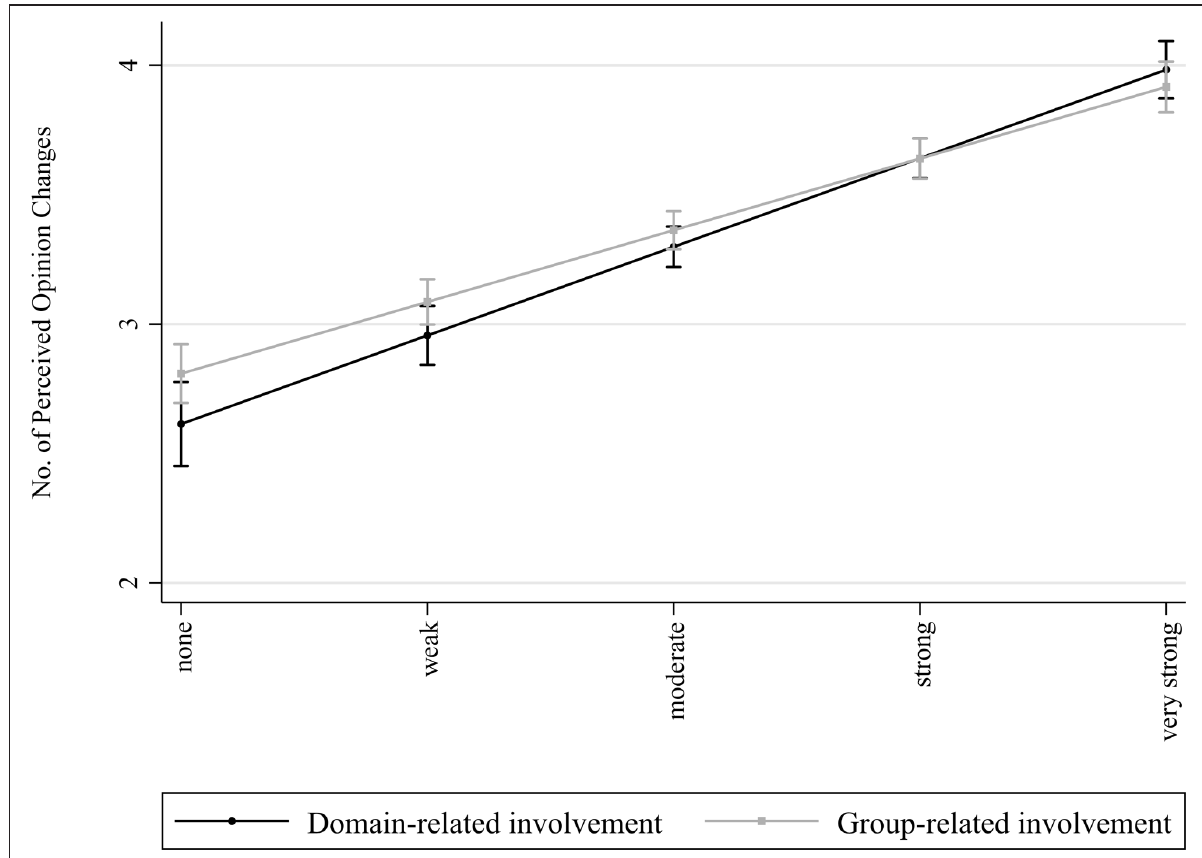
Figure 6: Predicted perceived number of opinion changes across all waves by levels of political involvement. Note: Probabilities are predictions for men of average education and age; Source: ZA6804, Version